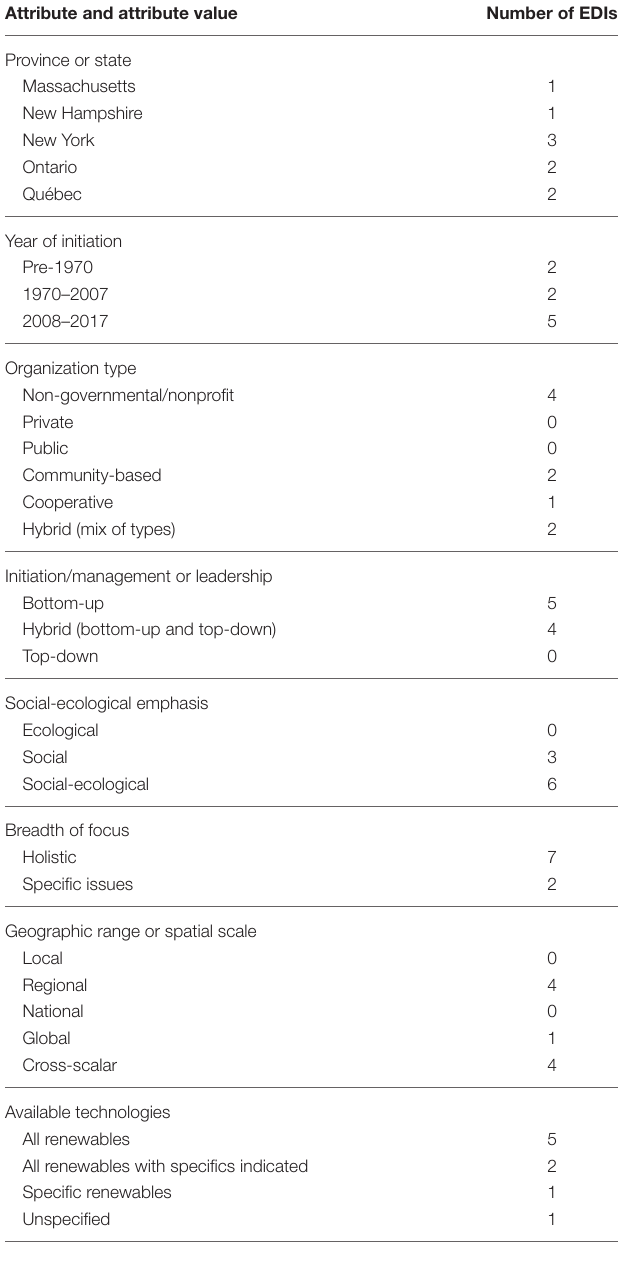
TABLE 2 | Number of Energy Democracy Initiatives (EDIs) by attribute value ( n = 9). Attribute and attribute value Number of